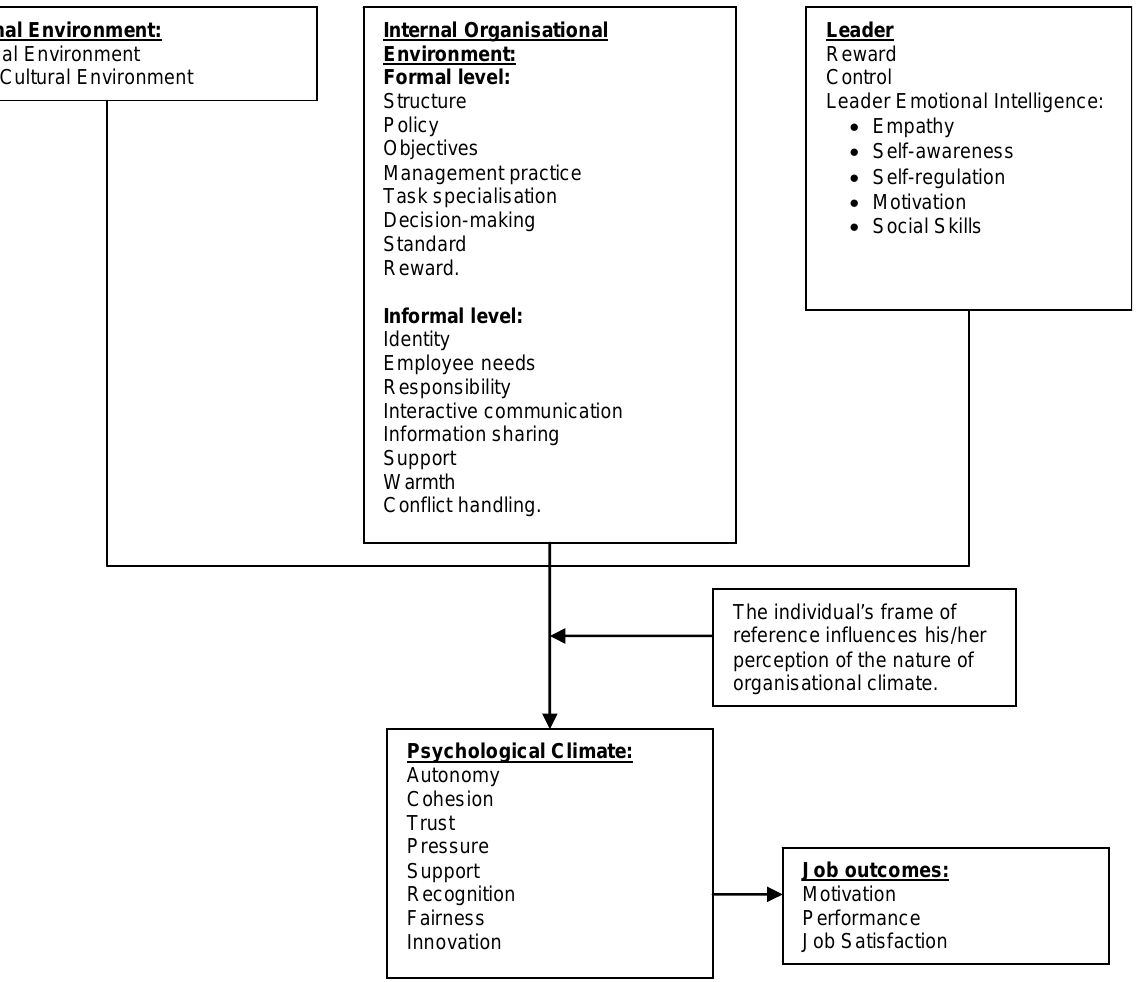
Figure 1: An integrated model of the antecedents of psychological climate (Adapted from Field & Abelson, 1982: 183) Measuring